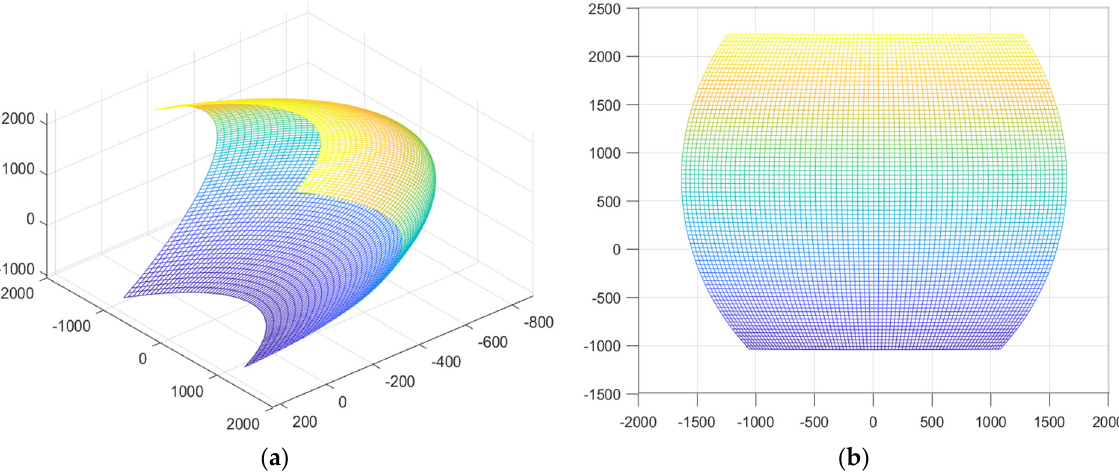
Figure 7. Simulation diagram of limit cutting section of the cutting head (d = 0 mm). ( a ) Three ‐ dimensional simulation diagram of cutting section. ( b ) Projection of cutting section on YOZ plane.